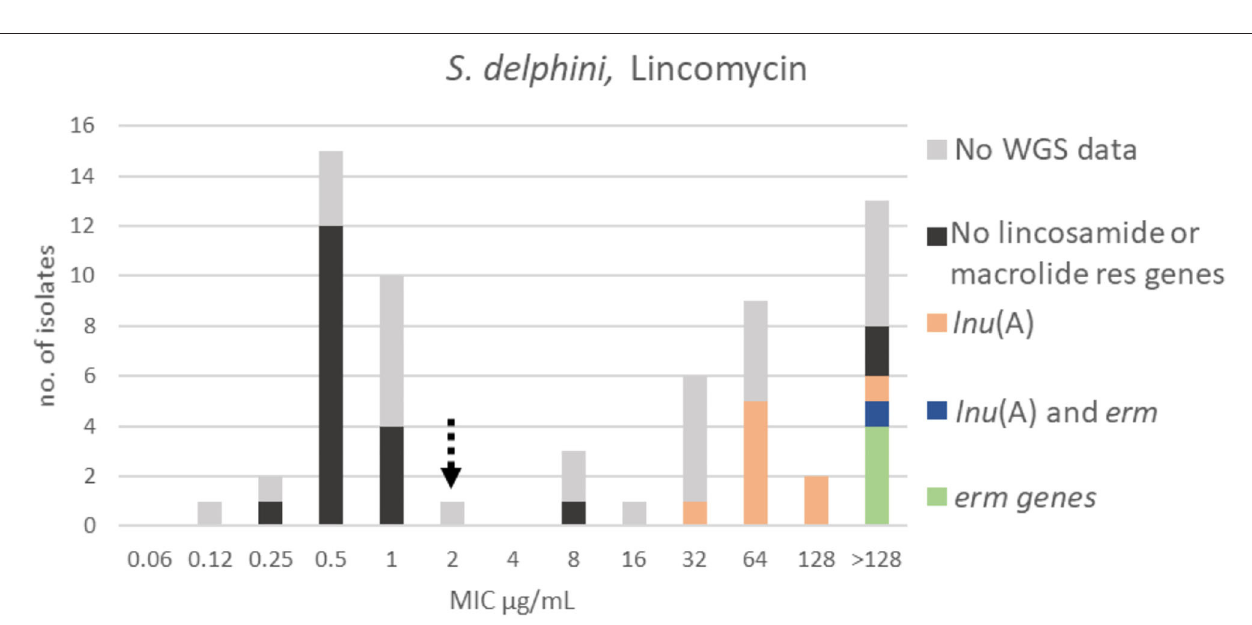
FIGURE 10 | MIC distribution of Staphylococcus delphini ( n = 63) against tylosin in the test range of 0.12–128 µ g/mL. The broken arrow indicates the tentative epidemiological cut-off value (TECOFF). Colors indicate if the isolates have been sequenced and whether they harbor known relevant resistance genes. WGS, whole-genome sequencing; res, resistance.